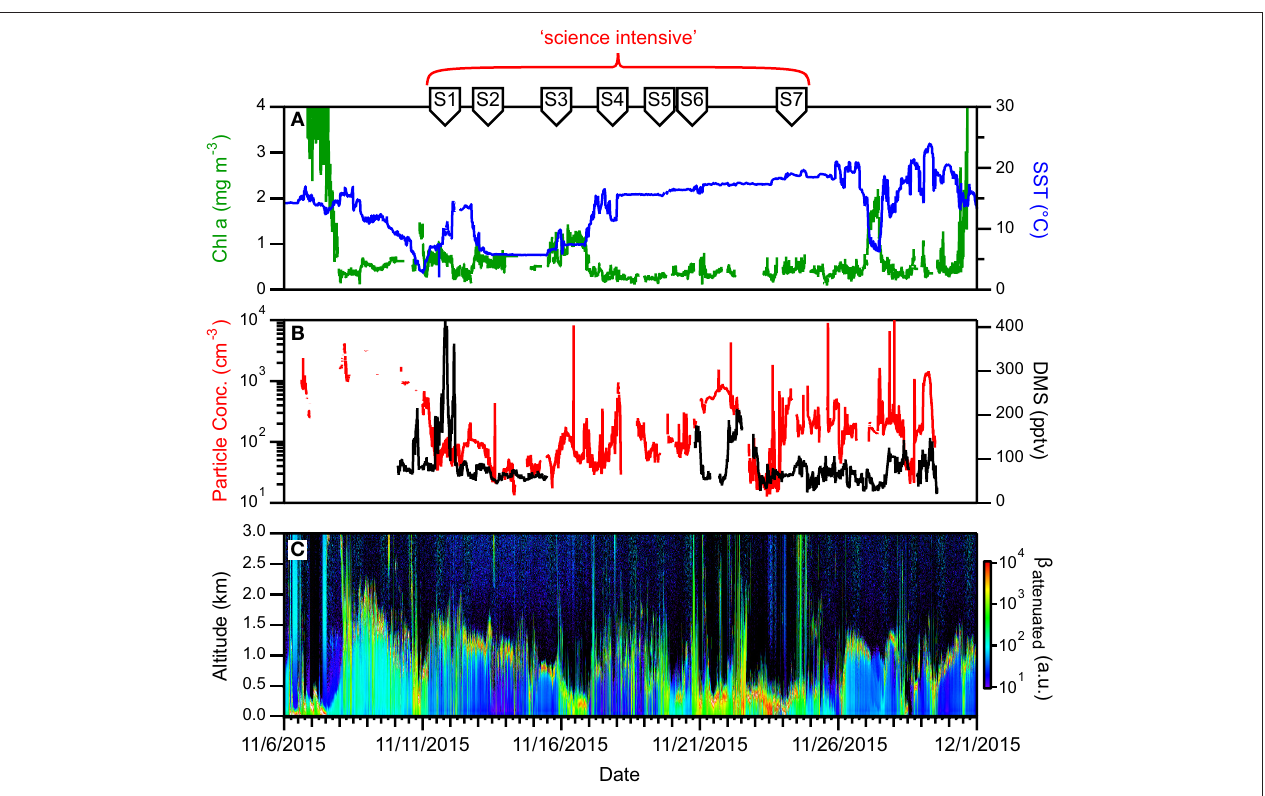
FIGURE 7 | Ocean and atmosphere properties as a function of campaign date during NAAMES 1. (A) Surface chlorophyll concentration (green line) and sea surface temperature (SST; blue line) as a function of hours along ship transit. (B) Particle number concentration (red line) and dimethylsulfide gas mixing ratio (black line) along the ship transit. (C) Attenuated backscatter curtain in arbitrary units as detected by the ship-based ceilometer along the ship transit. The record begins on 11/6/2015 at 40 ◦ 27 ′ N, 70 ◦ 2 ′ W on the outbound transit and ends on 12/1/2015 at 41 ◦ 30 ′ N, 70 ◦ 41 ′ W on the return transit. Red bracket = “science intensive” segment of transit. Labeled symbols at top of panel indicate ship location at the beginning of each primary station (S1–S7).